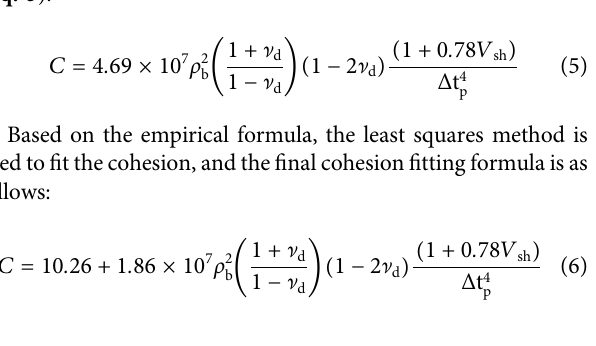
FIGURE 9 | Comparison of the tested and predicted values of the internal friction angle of the